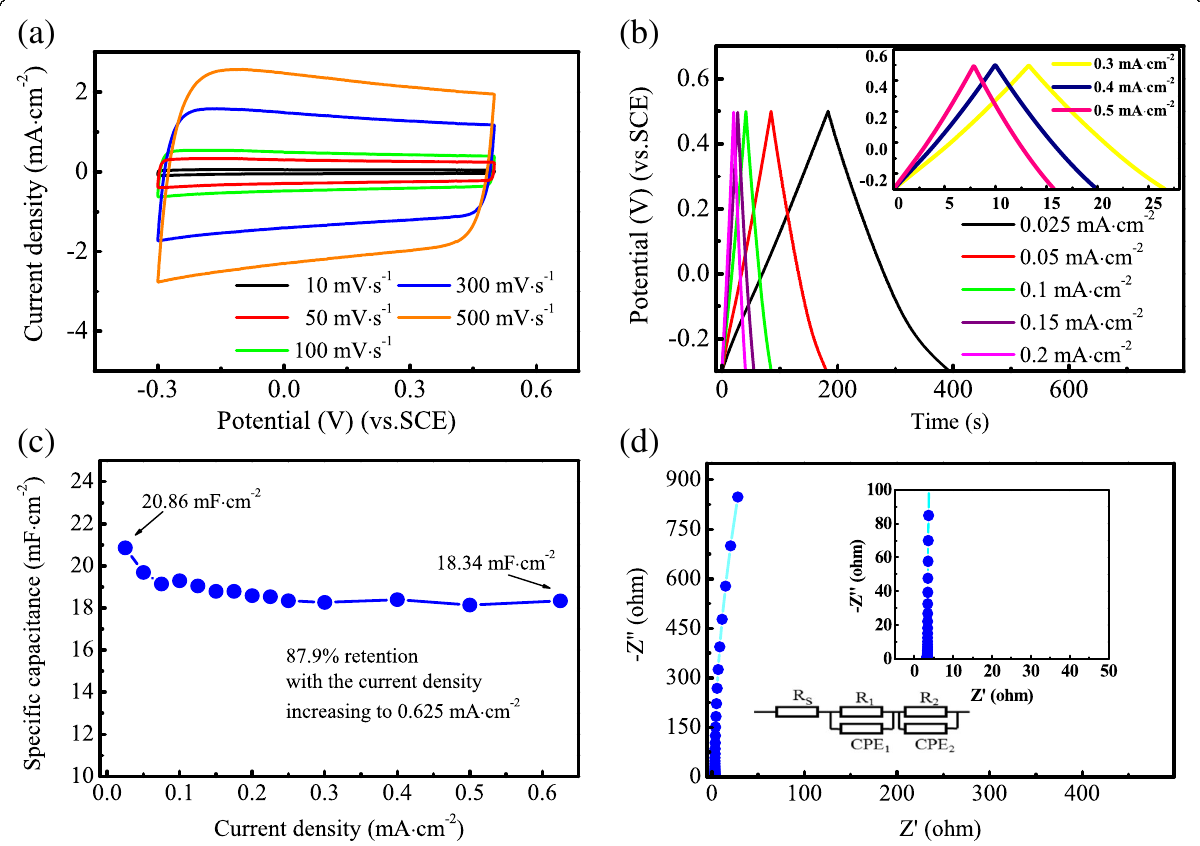
Fig. 5 Supercapacitive performance of H@TNAs-1. a CV curves collected at various scan rates ranging from 10 to 500 mV s − 1 . b Galvanostatic charge/ discharge curves at various current densities ranging from 0.025 to 0.5 mA cm − 2 , inset is the enlargement of the galvanostatic charge/discharge curves at higher current densities. c Nyquist plots collected at a frequency from 100 kHz to 10 mHz, with inset showing an enlargement of the high-frequency regions and a fitting equivalent circuit. d Specific capacitance of H@TNAs-1 measured as a function of current